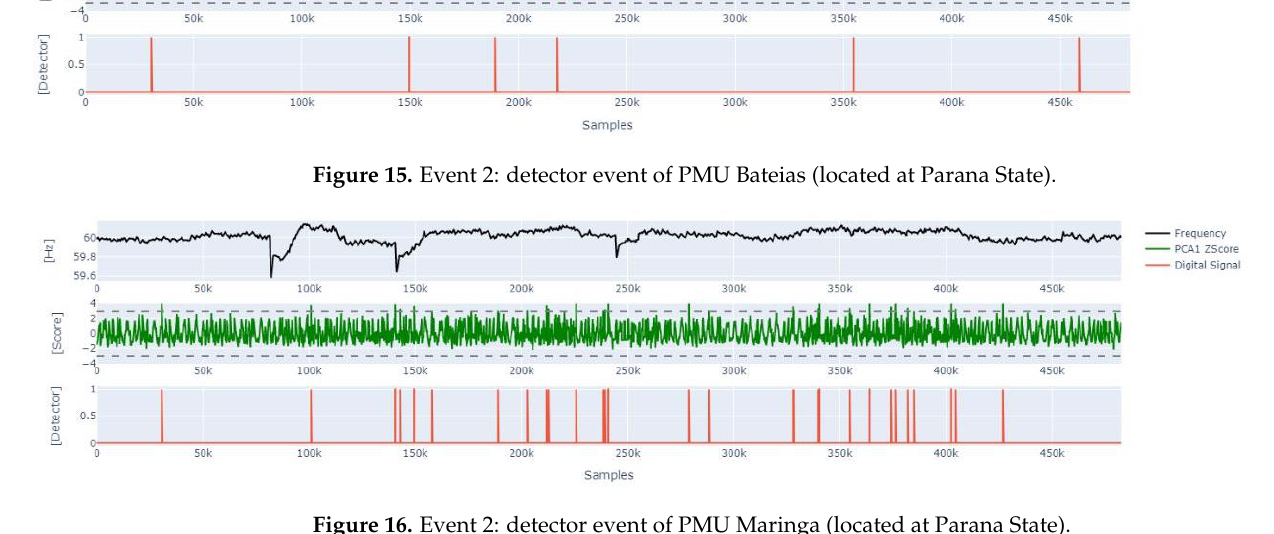
Figure 16. Event 2: detector event of PMU Maringa (located at Parana State).